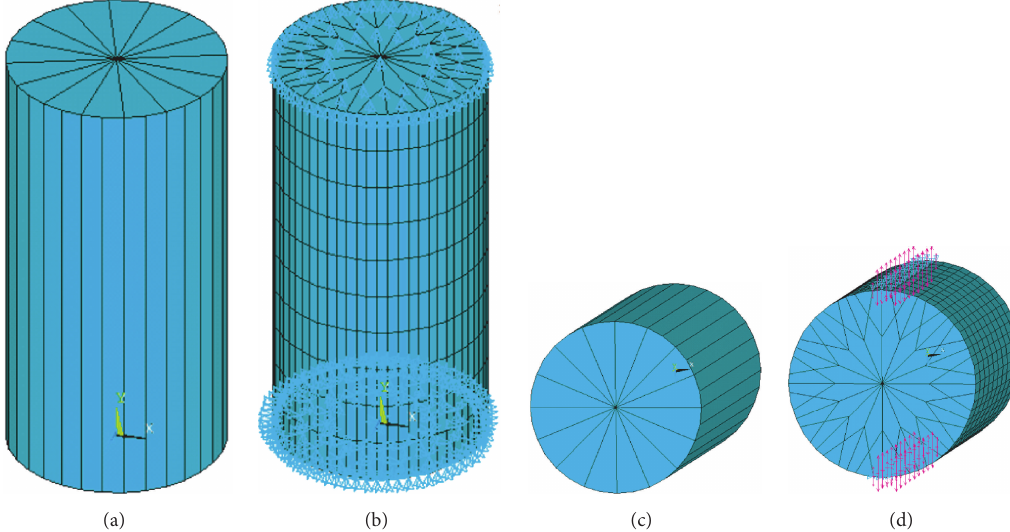
Figure 5: FE model and boundary condition (BC): ((a) and (b)) compression specimen before meshing and after meshing with BC, respectively, ((c) and (d)) splitting tensile specimen before meshing and after meshing with BC, respectively.